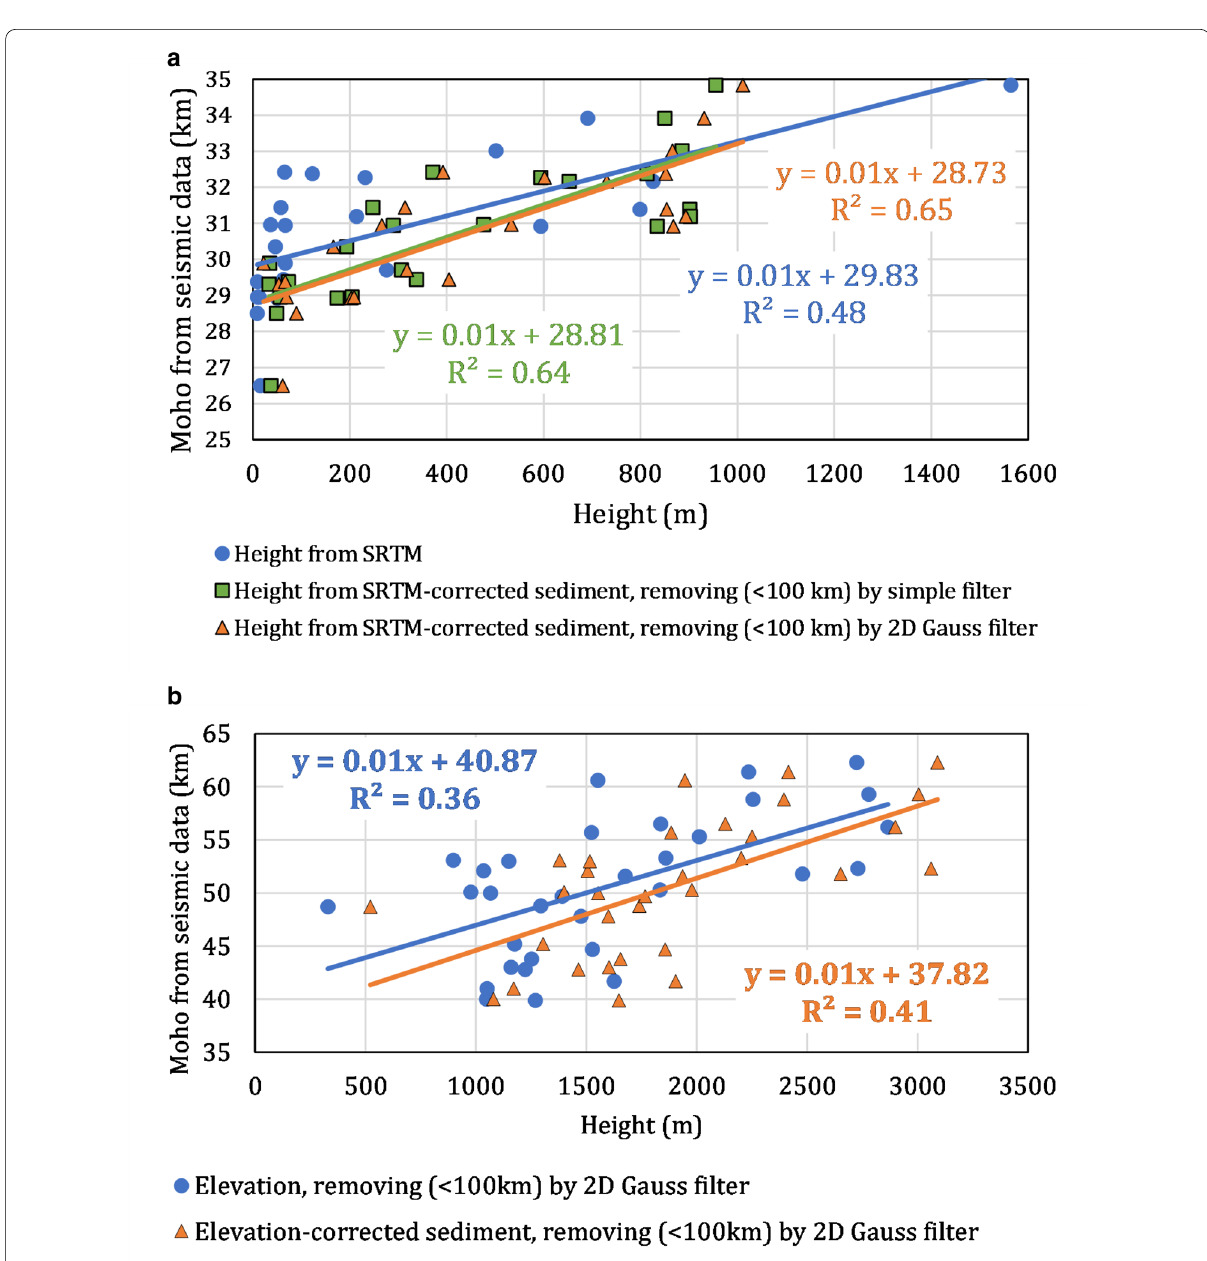
Fig. 6 Relation between Moho depths beneath seismic stations and corresponding elevation data: a in Vietnam and b in the test area (Central